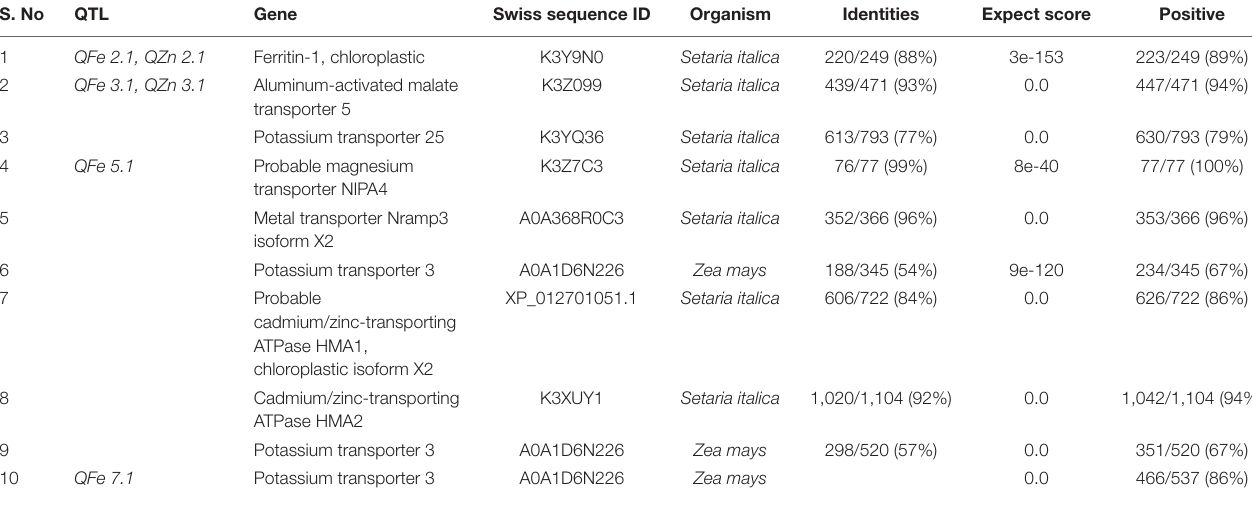
TABLE 10 | Identification of putative candidate gene within QTL involved in enhancing Fe/Zn content. S.